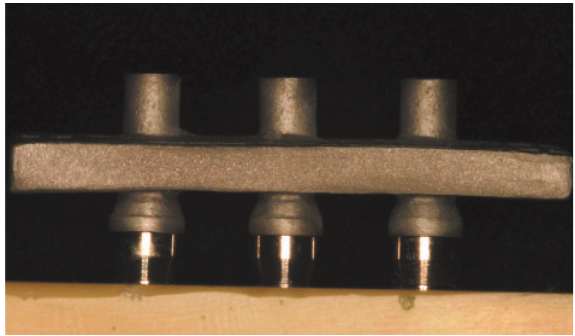
Figure 4- Fit and passivity of the